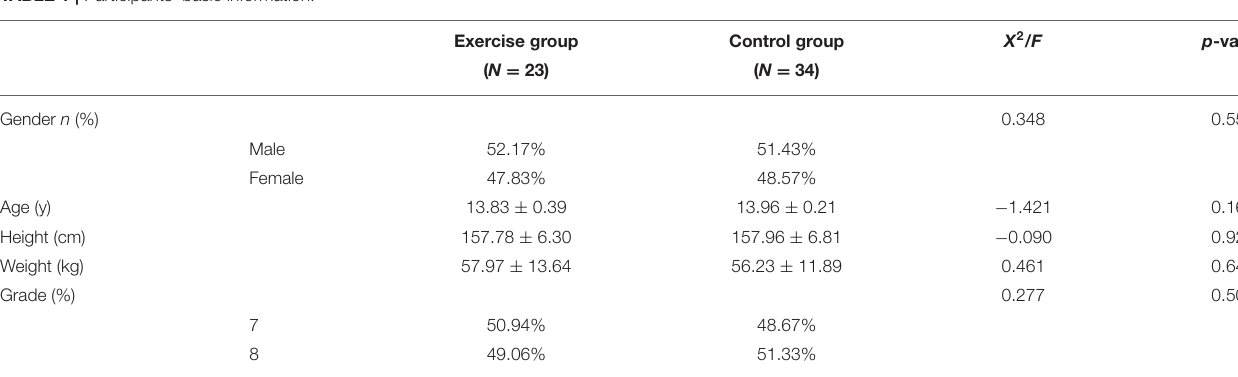
TABLE 1 | Participants’ basic information.